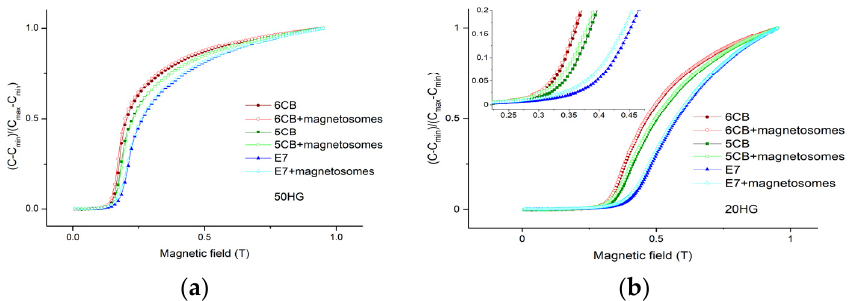
Figure 4. Reduced capacitance dependence of the pure LCs (5CB, 6CB, E7) as well as doped with magnetosome particles of concentration 0.2 wt% on the external magnetic field for samples in 50 µm ( a ) and 20 µm ( b ) cells. The insert in ( b ) shows detail in the vicinity of threshold magnetic fields. Since the threshold magnetic field depends inversely proportional on the sample thickness, the measurements in 50 µ m show cell full transition region while the measure- ments for samples in 20 µ m cell show the region around threshold magnetic field. The reduced capacitance dependences on the magnetic field acquired for samples in 20 µ m cells (Figure 4b) show a slight shift to lower values for liquid crystal 5CB and E7 doped with magnetosomes compared to pure liquid crystals. The threshold magnetic fields of liquid crystals and composites in 20 µ m cells are listed in Table